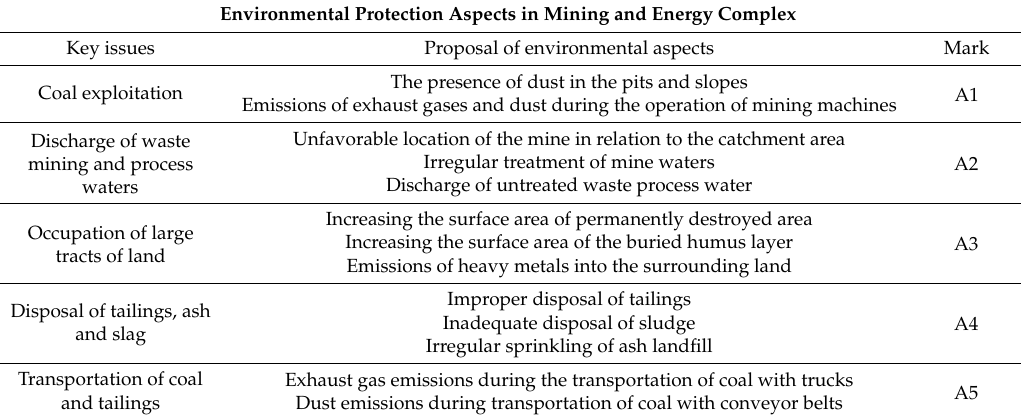
Table 2. Selection of environmental aspects.